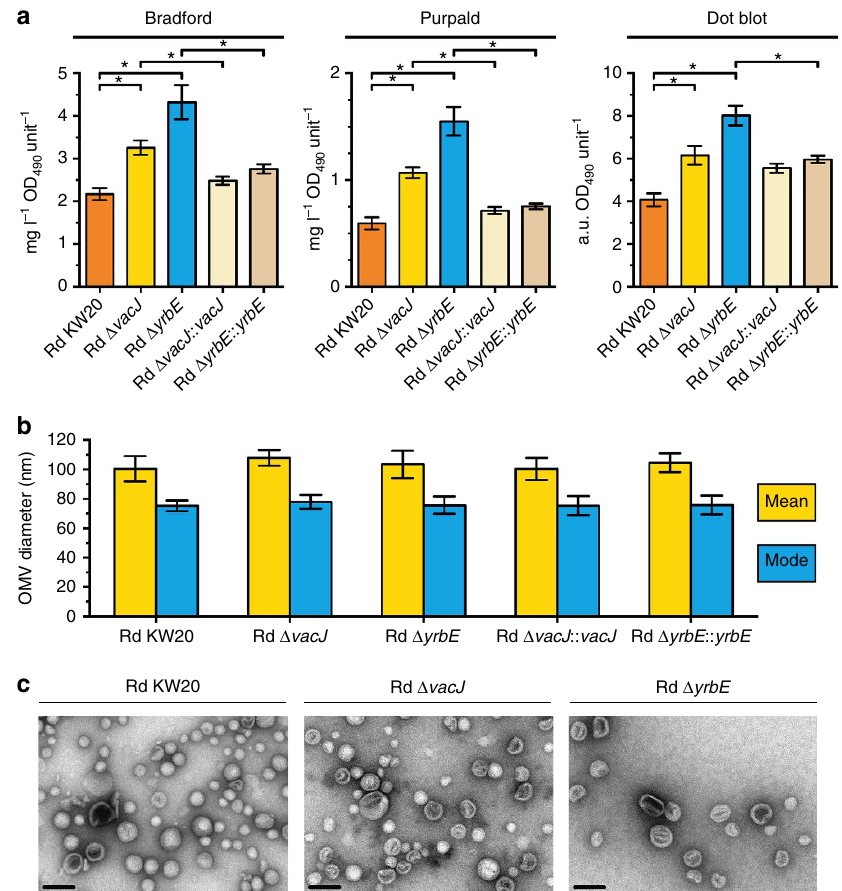
Figure 2 | H. influenzae PL transporter mutants produce excessive OMVs. ( a ) OMV preparations derived from equivalent OD 490 units of cultured wild- type (Rd KW20), deletion mutants (Rd D vacJ and Rd D yrbE ) and complementation strains (Rd D vacJ :: vacJ and Rd D yrbE :: yrbE ) were analysed for total protein (Bradford), lipooligosaccharide (Purpald) or OMV specific proteins (Dot blot). Mean values with standard error of the mean (s.e.m.) are shown ( n ¼ 6 biological replicates). Significant differences between the data sets are marked by asterisks ( P o 0.05; one-way ANOVA followed by Sidak’s multiple comparison post test). ( b ) Distributions of OMV sizes produced by the strains were determined by nanoparticle tracking analysis. Mean values with standard deviation (s.d.) of mean and mode OMVdiameter sizes within each OMV preparation are shown ( n ¼ 6 biological replicates). ( c ) Visualization of density gradient purified OMVs by transmission electron microscopy. Shown are representative micrographs. Scale bars,